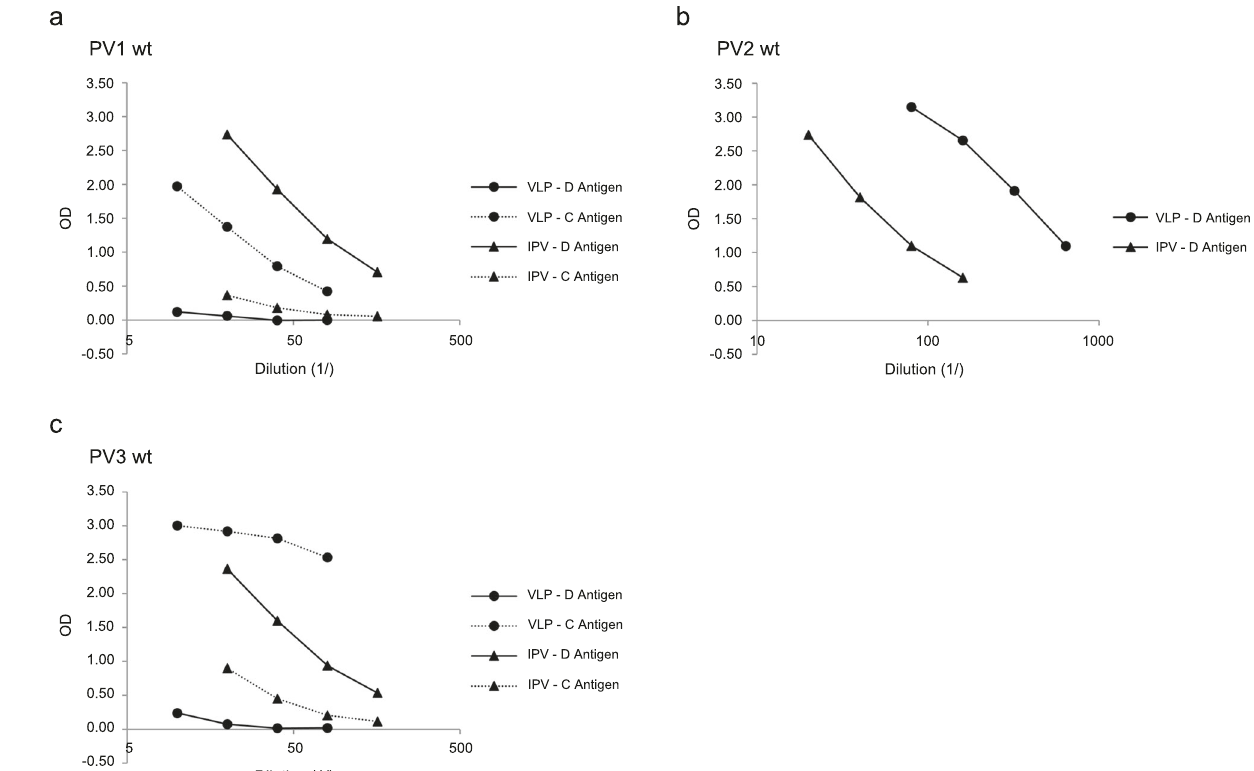
Fig. 5 The antigenicity pro fi le of wt VLPs for PV1, PV2 and PV3 as assessed by ELISA using monoclonal antibodies speci fi c for either native (D) or non-native (C) conformations. a – c D and C-antigenicity of PV1 wt, PV2 wt and PV3 wt VLPs and IPV control respectively. Monoclonal antibodies used for detection were: 234 for PV1, 1050 for PV2 and 520 for PV3 (D-antigen speci fi c) and 1588 for PV1 and 517 for PV3 (C-antigen speci fi c). There was no C-antigen speci fi c antibody available for PV2